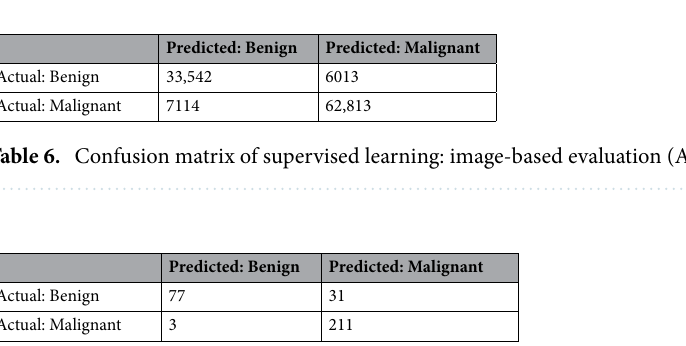
Table 7. Confusion matrix of Supervised learning: case-based evaluation (AlexNet-like model).